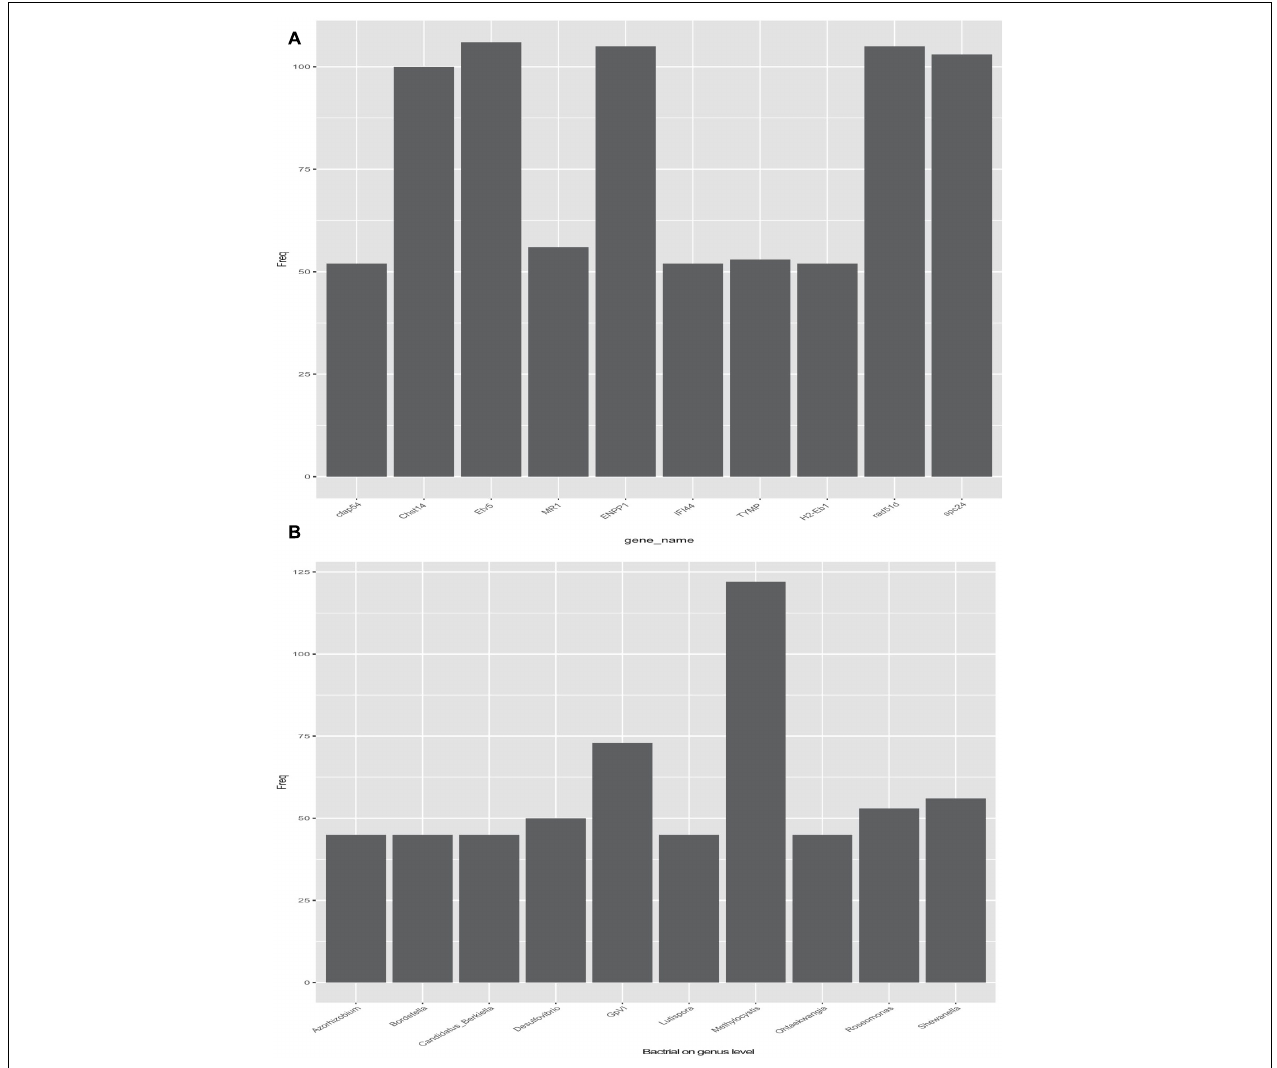
FIGURE 4 | Relationship between differentially expressed genes (DEGs) and bacteria (genus level) in the selection (Huanghe carp new strain 4th generation) and control lines. (A) Top 10 DEGs related to gut bacteria. (B) Top 10 bacterial genera related with DEGs.